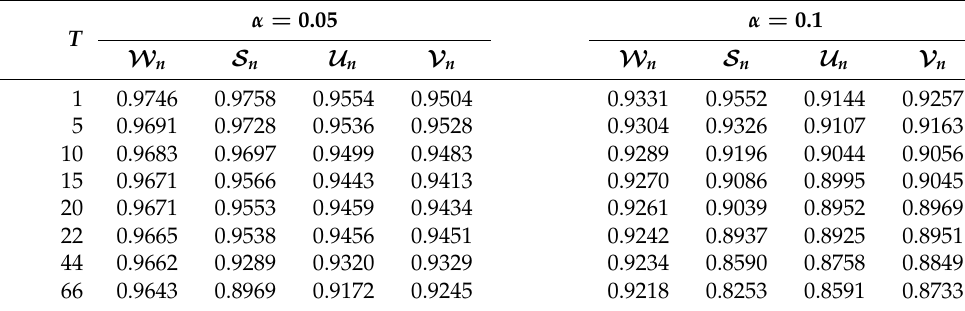
Table 2. Coverage rates of the test statistics under H 0 .